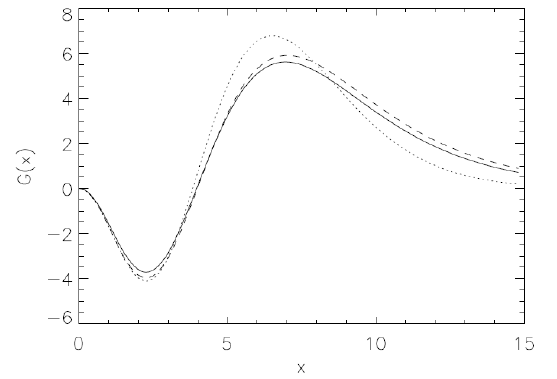
Figure 3: The SZE intensity spectra for a massive cluster with a temperature of kT e = 15 . 3 keV for Jut- tner (solid) and Maxwell-Boltzman (dashed) DFs. The non-relativistic SZE spectrum (solid) is also shown for comparison. Figure from